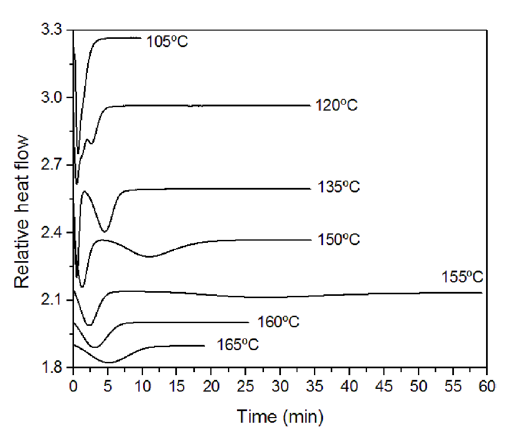
Figure 5. DSC curves of isothermal crystallization at different temperatures for scPLA/GNPO+ nanocomposite.